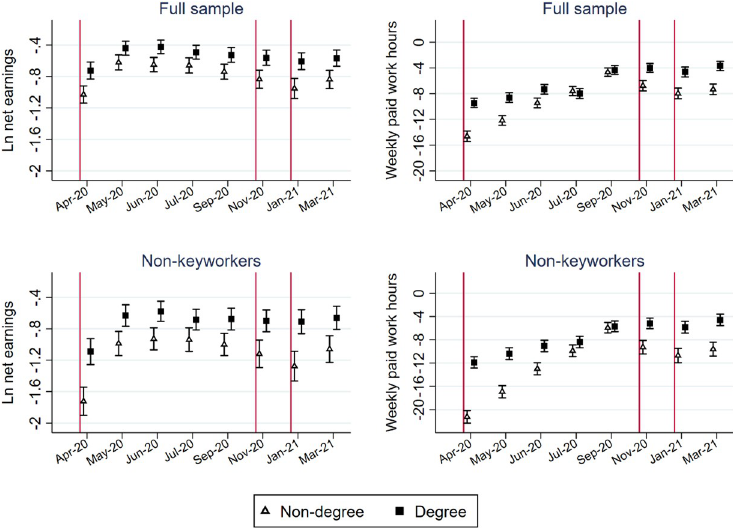
Fig 8. Point estimates and 95% confidence interval of the education-period interaction models.